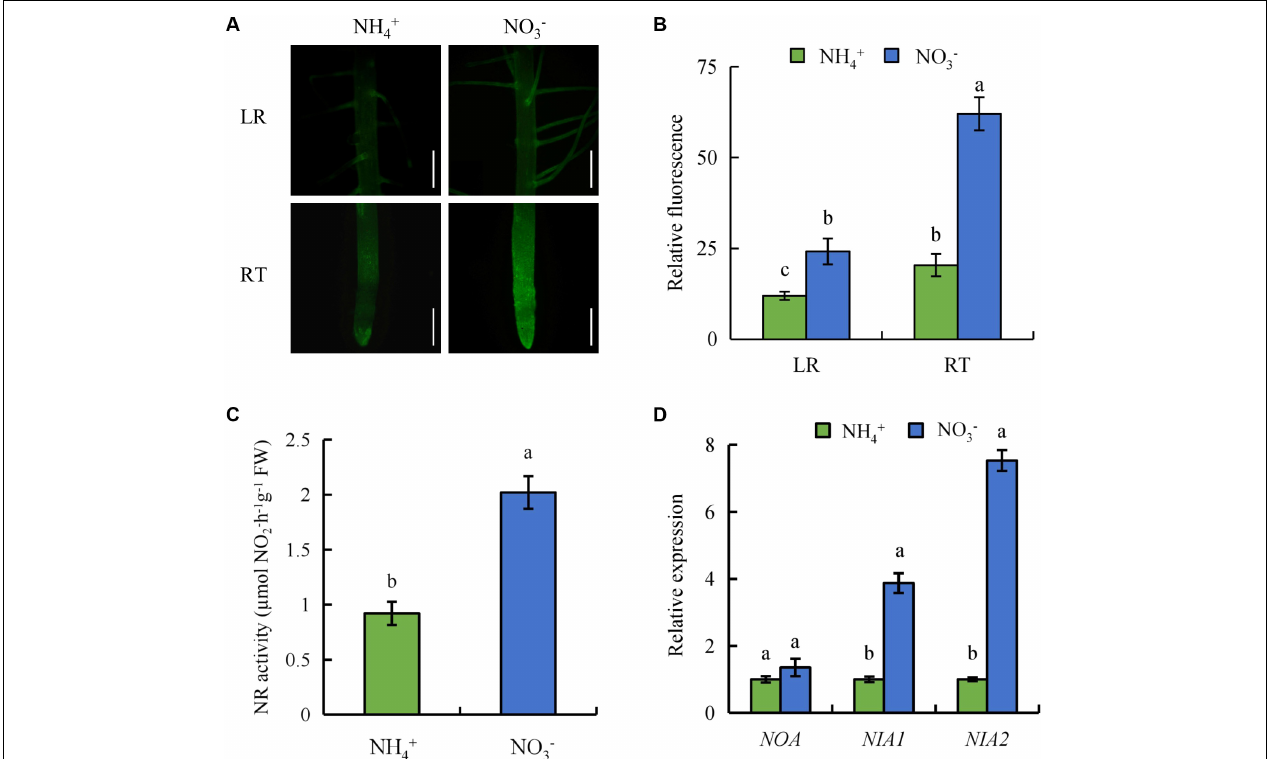
FIGURE 2 | Accumulation of nitric oxide (NO), relative nitrate reductase (NR) activity, and qRT-PCR analysis of NO-associated ( NOA ), NIA1 , NIA2 genes in wild-type (Nipponbare) rice seedlings. Seedlings were grown in hydroponic medium containing NH 4 + and NO 3 − for 14 days. (A,B) , Photographs of NO production shown as green fluorescence in the lateral root (LR) and root tip (RT) (A) ; and NO production expressed as fluorescence intensity relative to the roots (B) ; (C) , Relative nitrate reductase (NR) activity in the roots; (D) , Relative expression of NOA , NIA1 and NIA2 in roots. Bar = 1 mm. Data are means ± SE and bars with different letters indicate significant difference at P < 0.05 tested with